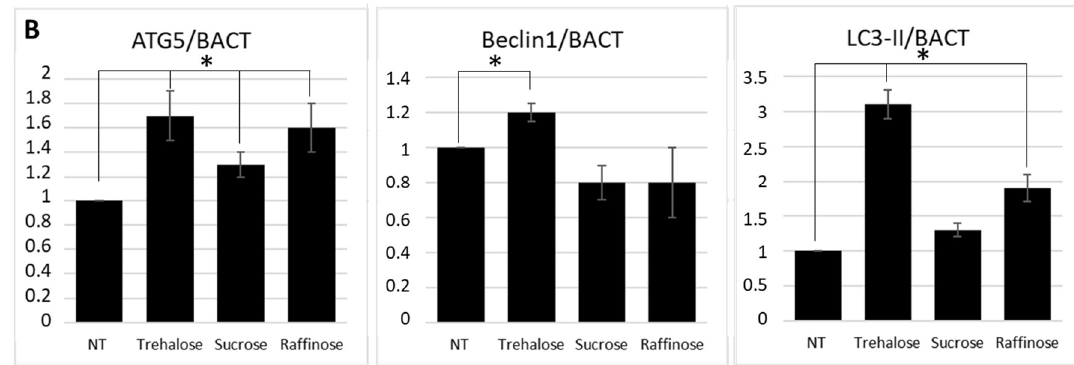
Figure 8. Immunoblotting of ATG5, Beclin1, and LC3-II protein levels ( A ) and relative densitometric analysis ( B ). Caco-2 confluent cells were treated with trehalose, raffinose, and sucrose (100 mM) and collected after 24 h p.t. Protein expression levels were normalized to BACT levels. Normalized values are reported on the y-axis as arbitrary units. Molecular weights (kDa) are reported. The asterisks indicate p < 0.05, ANOVA one-way, as compared with the NT sample. SE bars are reported. Experiments were performed in duplicate.